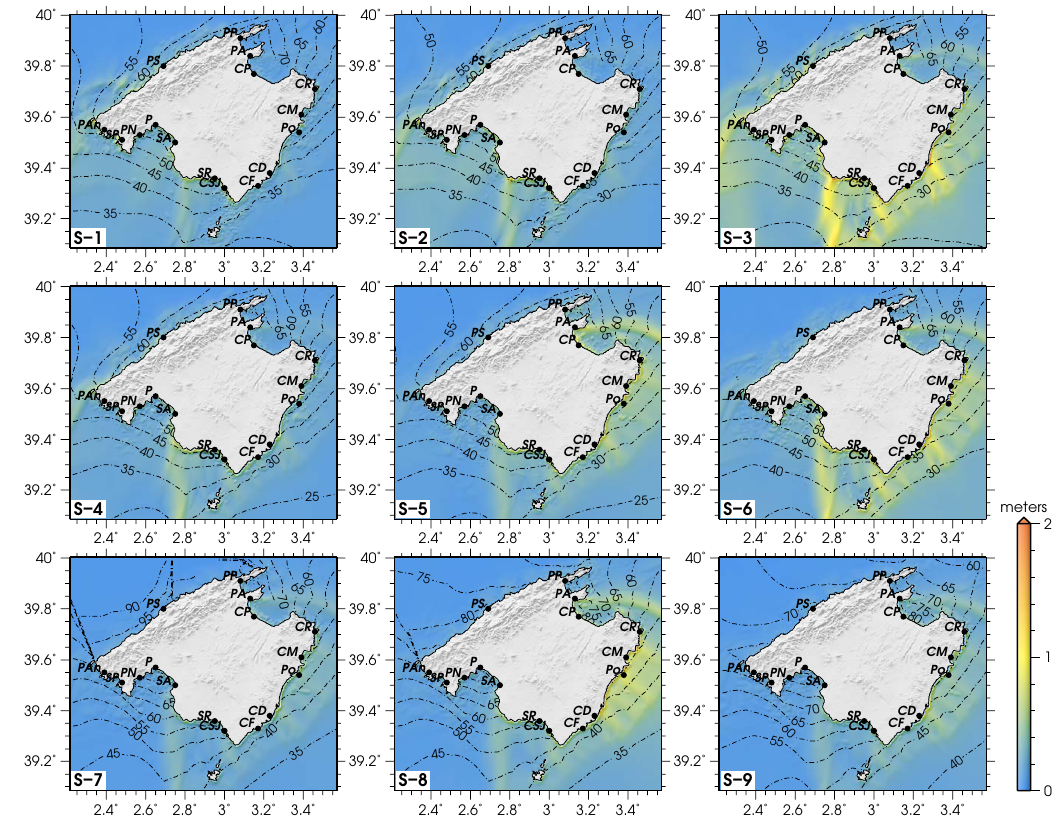
Fig. 7. Maximum wave elevation maps and estimated tsunami travel times for Majorca Island. The shading represents the wave elevation value as shown in the colour scale at the right. The contours show the tsunami travel time in 5min steps from the source. Black dots show the location of relevant populations: P, Palma; SR, Sa Rapita; CSJ, Col`onia Sant Jordi; CF, Cala Figuera; CD, Cala D’Or; Po, Portocristo; CM, Cala Millor; CR, Cala Rajada; CP, Can Picafort; PA, Port d’Alcudia; PP, Port de Pollenc¸a; PS, Port de Soller; PAn, Port d’Andratx; SP, Santa Ponc¸a; PN, Portals Nous; SA,